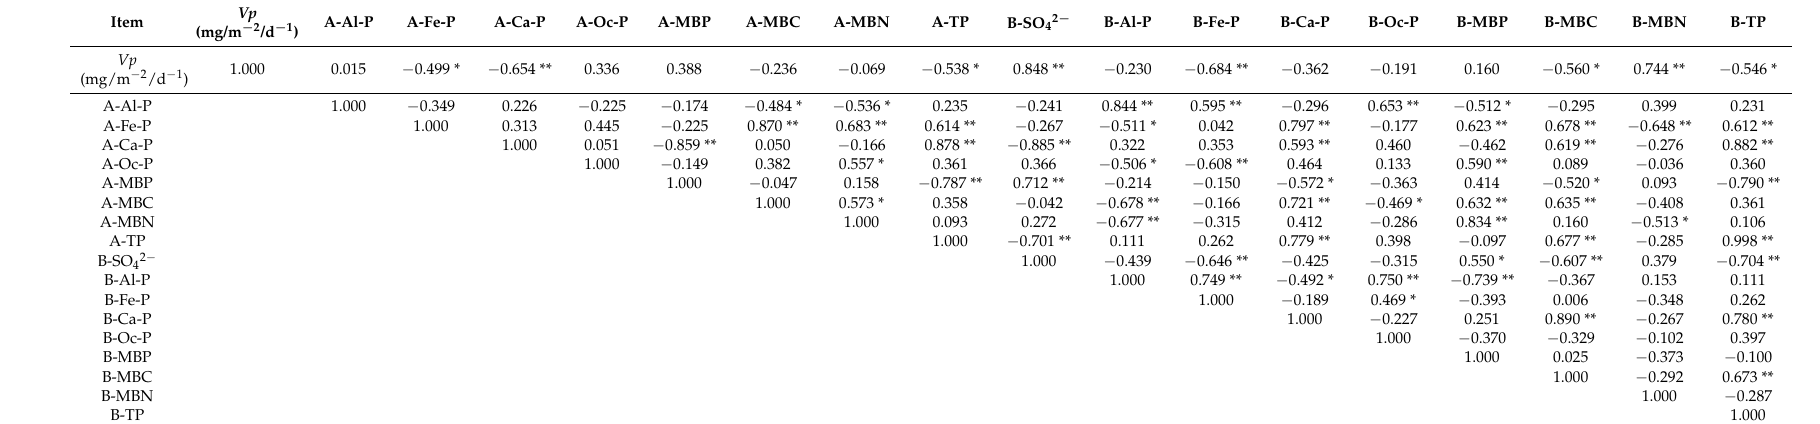
Table 3. The correlation coefficient of sediment P release rates ( V P ) and other factors (unit: